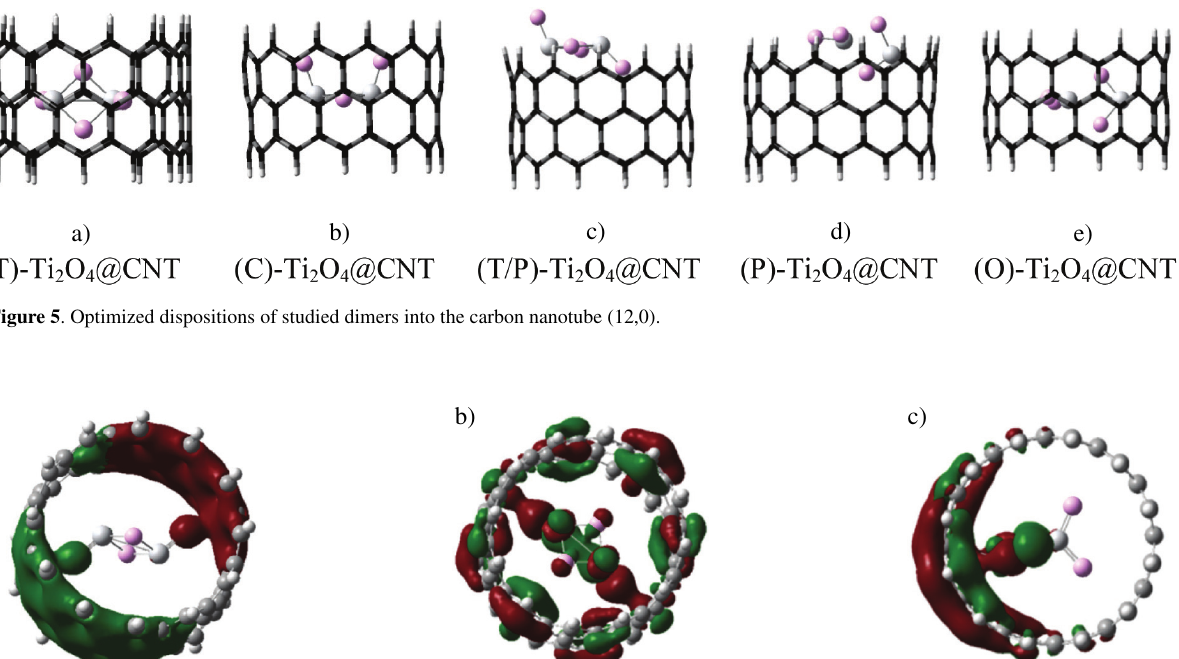
dimers: a) Trans, E = –0.92013au, b) Cis, E = –0.29406 au and c) Orthogonal, E = 2